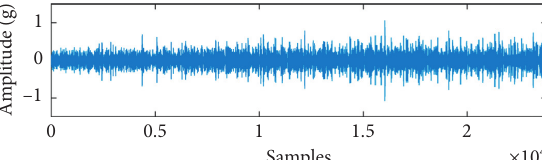
Figure 21: The denoised signal of outer race